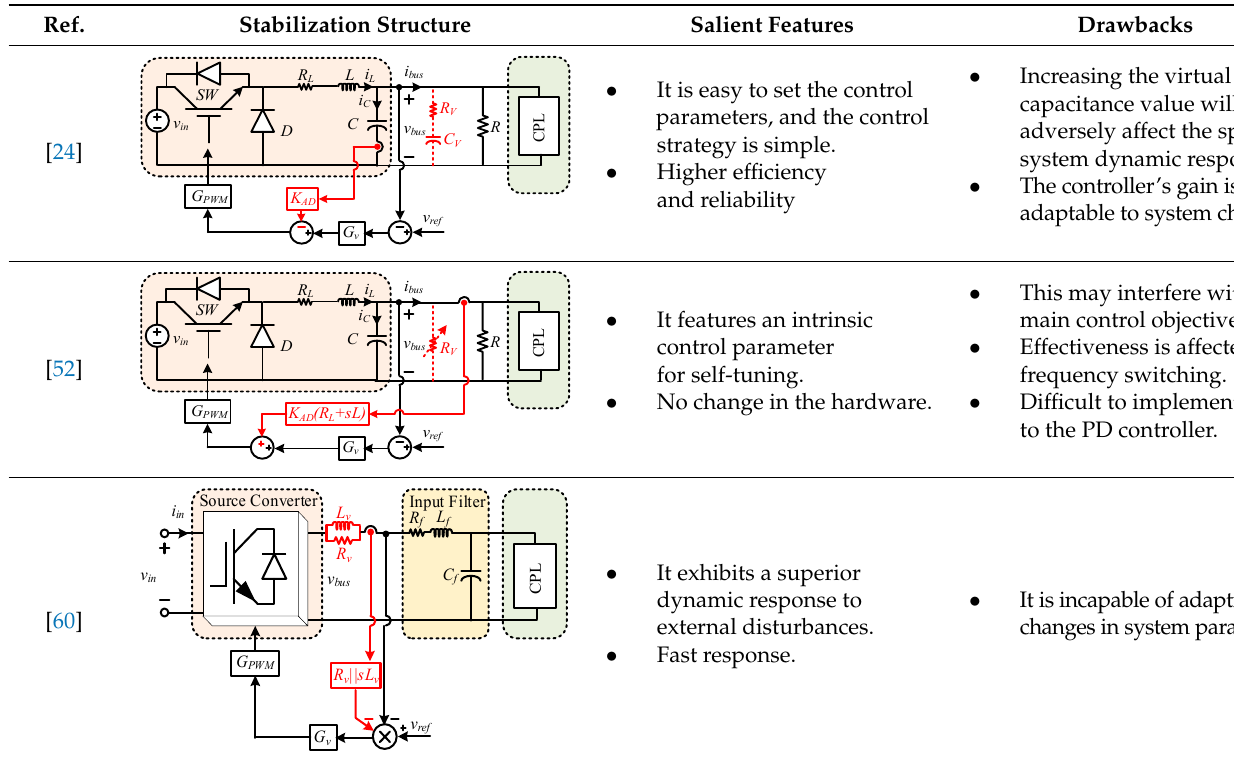
Table 1. Summary of source-side CPL compensation techniques.